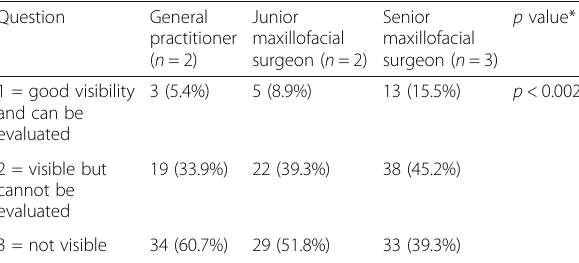
Table 3 Number of additional incidental findings in PAN and sFOV-CBCT not related to the sinus disease that led to